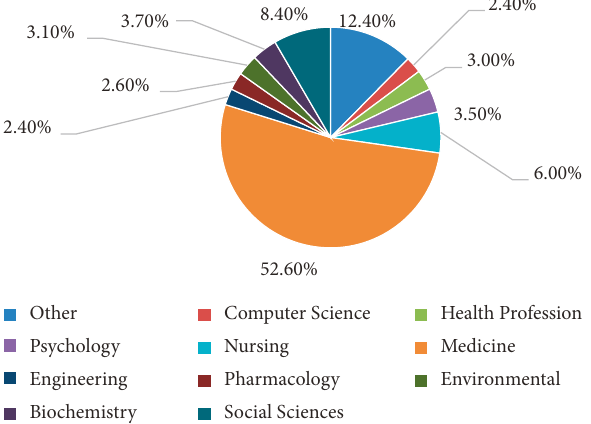
Figure 2: Pie chart depicting article distribution by disciplines for rapid review articles.